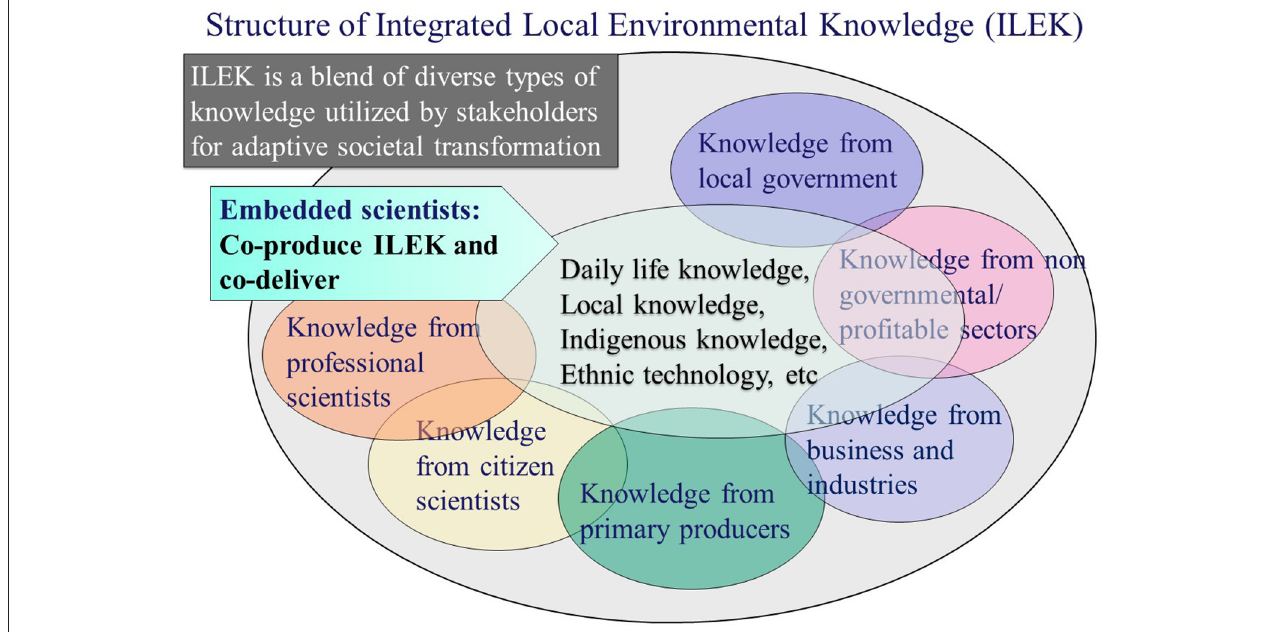
FIGURE 2 | Conceptual diagram of integrated local environmental knowledge (modified from Sato,